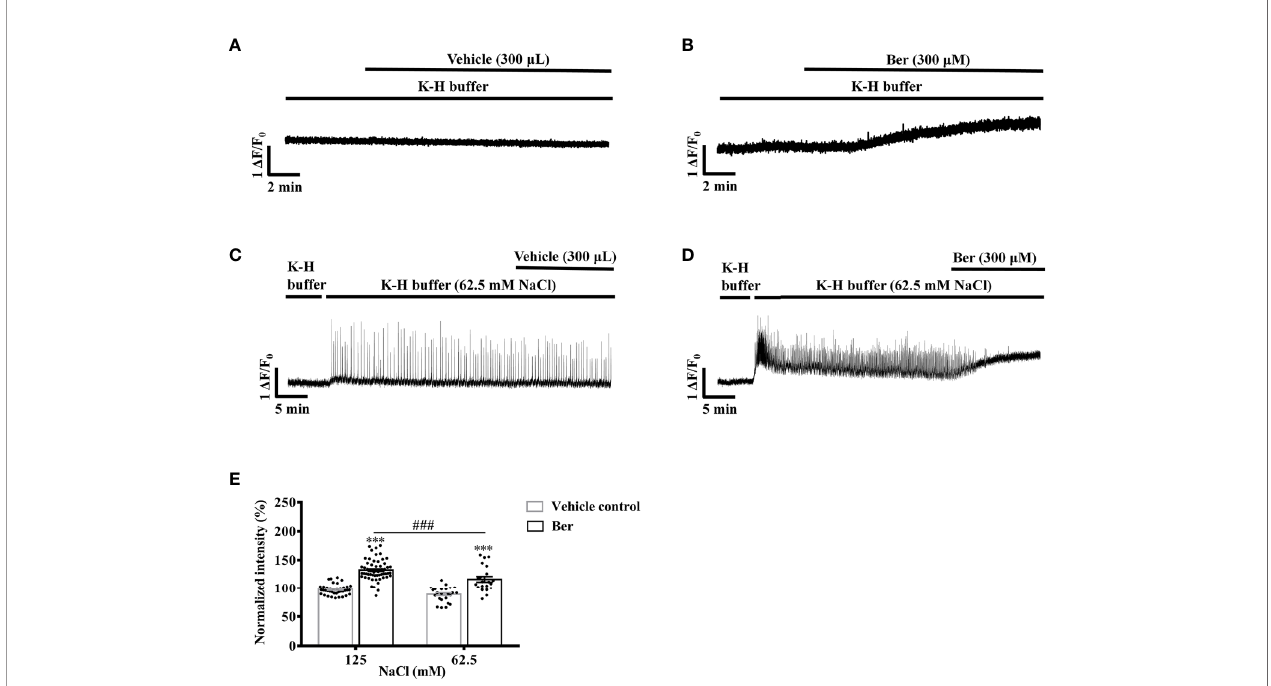
FIGURE 12 | The berberine-induced increase in the intracellular Ca 2+ level of left ventricular (LV) myocytes was extracellular Na + -dependent. (A – D) Original Ca 2+ imaging recordings of the LV myocytes treated with vehicle (A) and 300 m M Ber (B) ; vehicle (C) and 300 m M Ber (D) in the modi fi ed Krebs-Hensseleit (K-H) buffer containing 62.5 mM NaCl and 62.5 mM NMDG, respectively. (B) Summary data indicating that the berberine-induced increase in the intracellular Ca 2+ level in a buffer containing 62.5 mM NaCl was smaller than that in a buffer containing 125 mM NaCl. The numbers of repeats are as follows: vehicle control of 300 µM Ber, n = 42, N = 3; 300 µM Ber, n = 58, N = 3; vehicle control of 300 µM Ber in the K-H buffer containing 62.5 mM NaCl, n = 24, N = 3; 300 µM Ber in the K-H buffer containing 62.5 mM NaCl, n = 21, N = 3; n and N are the numbers of LV myocytes and rats, respectively. Ber stands for berberine. ***p < 0.001 vs. vehicle control group; ### p < 0.001 vs. Ber-treated group in the modi fi ed K-H buffer containing 125 mM NaCl; two-way ANOVA with Tukey's multiple comparisons